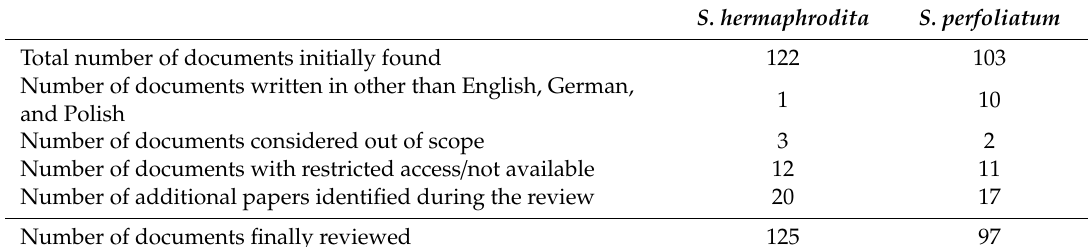
Table 1. Screening process for the systematic literature review and number of